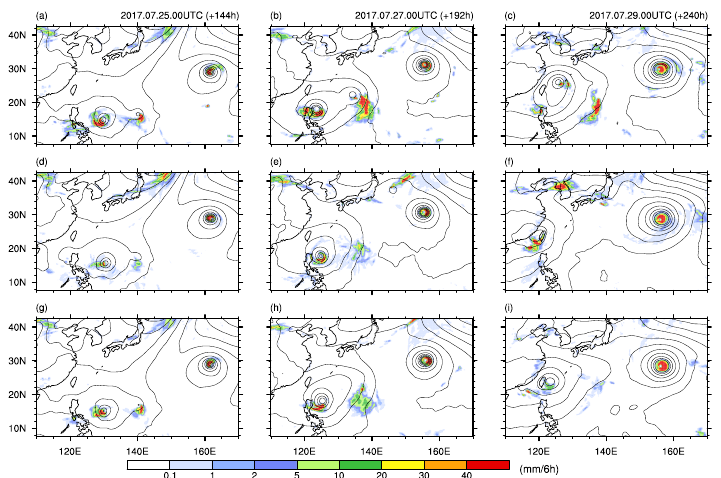
Figure 6. Fields of the six-hourly grid-scale precipitation rate (shaded; mm 6 h − 1 ) at 0000 UTC on July ( a ) 25, ( b ) 27, and ( c ) 29, 2017 in the CTL experiment, and the same fields in the NTDK experiment ( d – f ) and in the MOD experiment ( g – i ). Sea-level pressure contours (4 hPa interval) are presented with the precipitation rate